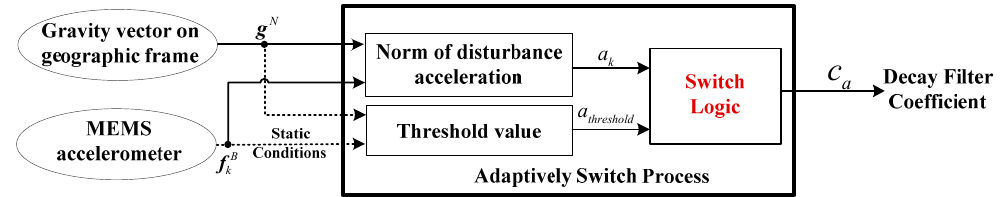
Figure 2. Adaptive switch process of filter decay coefficient c a .